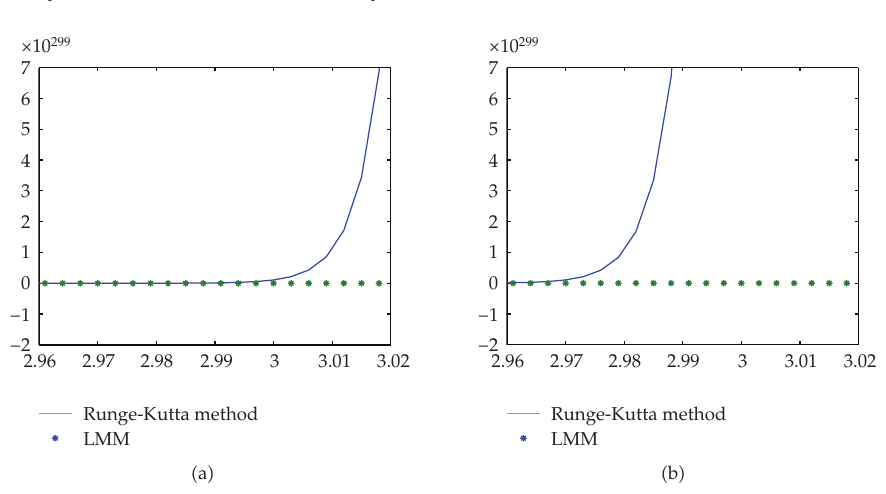
Figure 6: Errors of Runge-Kutta method and LMM (cid:3) 4.28 (cid:4) with h (cid:5) 0 .